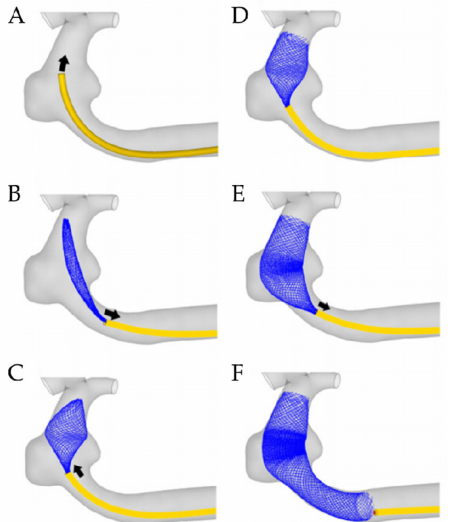
Figure 6. Stepwise deployment of stent [69]. ( A ) the delivery of stent; ( B – F ): the retraction of microcatheter and expansion of